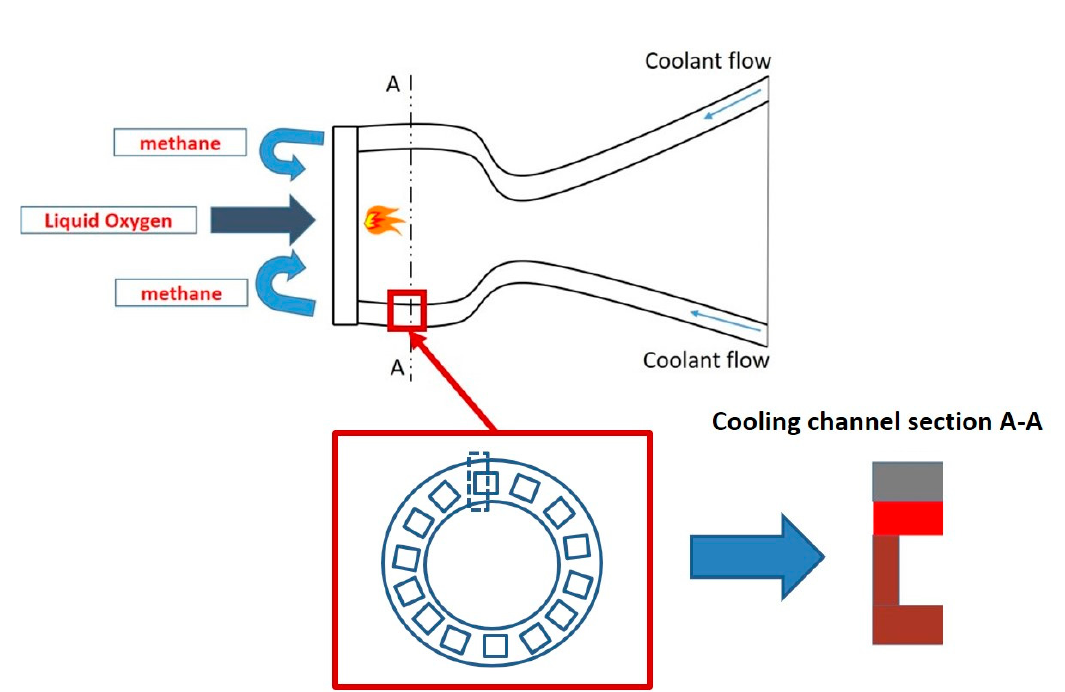
Figure 1. Schematic representation of a liquid rocket engine thrust chamber.